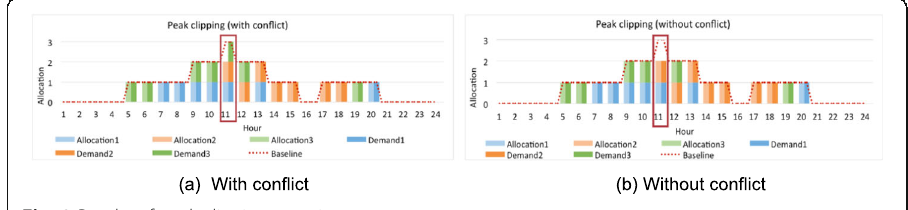
Fig. 8 Results of peak clipping